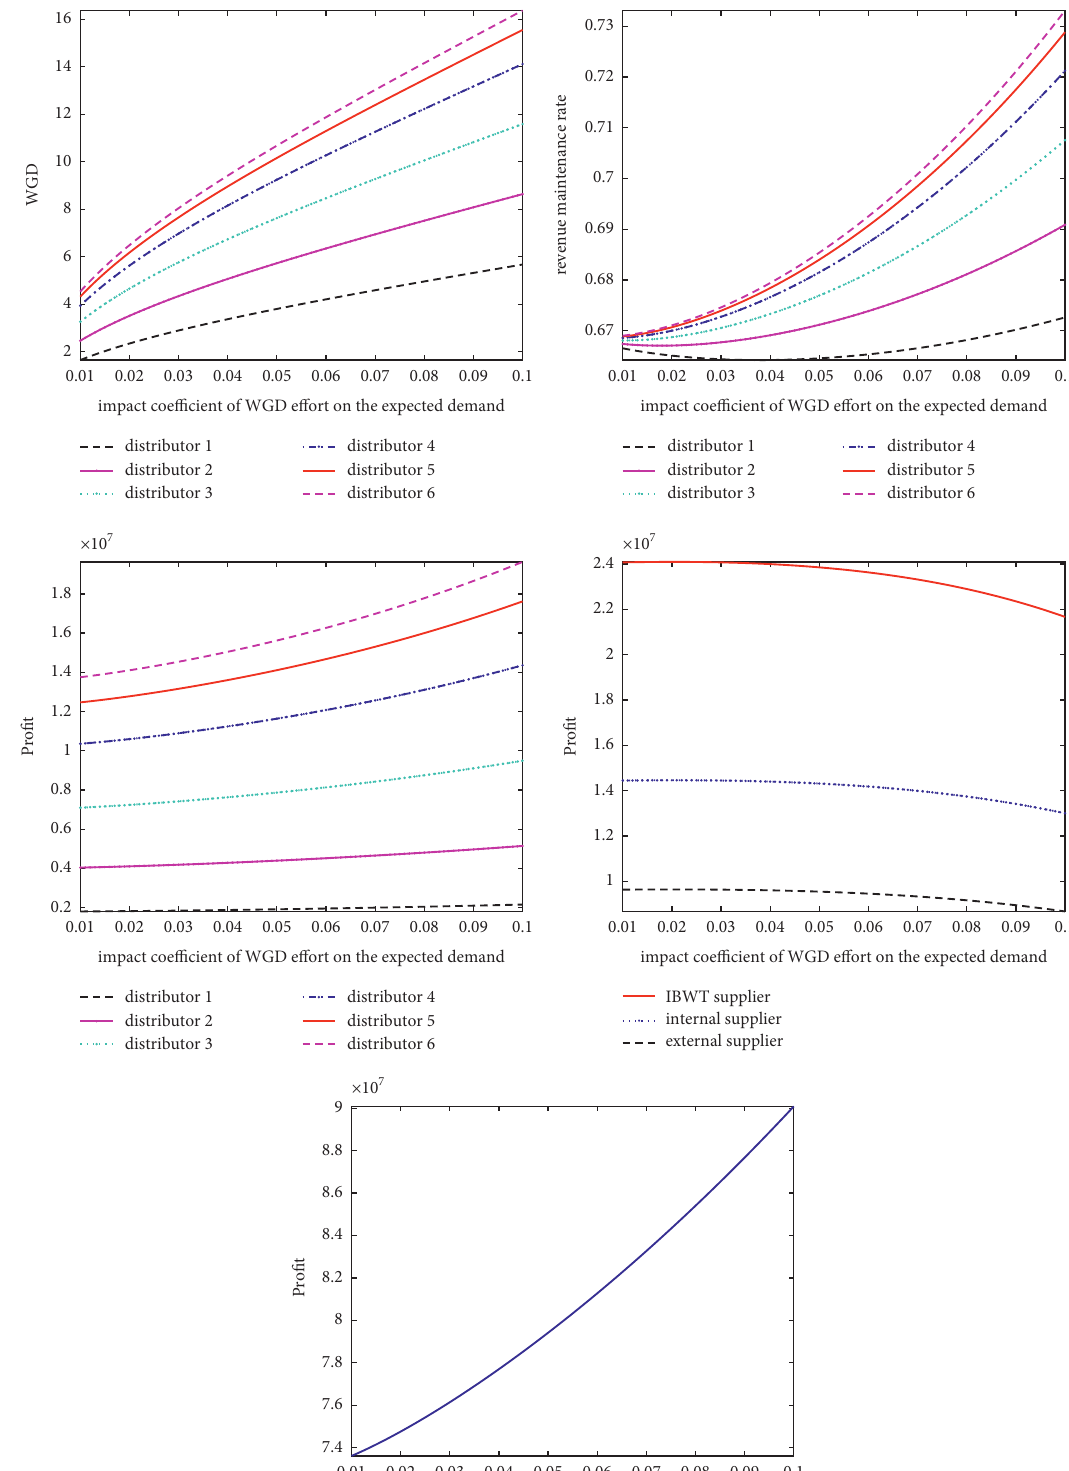
Figure 2: Sensitivity analysis of impact coefficient of WGD effort on the anticipated demand ( θ